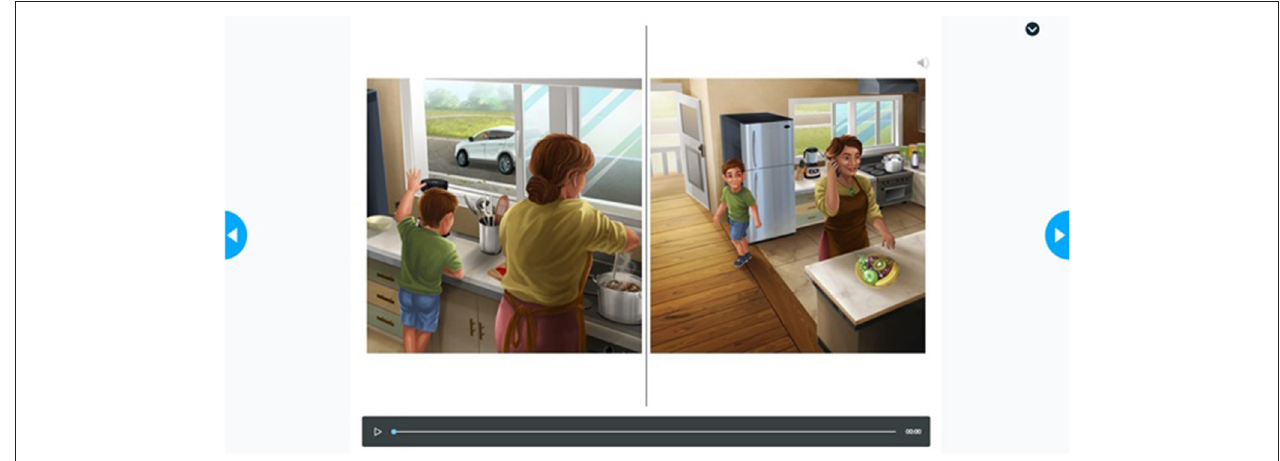
FIGURE 2 | Example of the presentation of the story Tama and the Playground from Phase 1. Reproduced with permission from UC Child Well-being Research